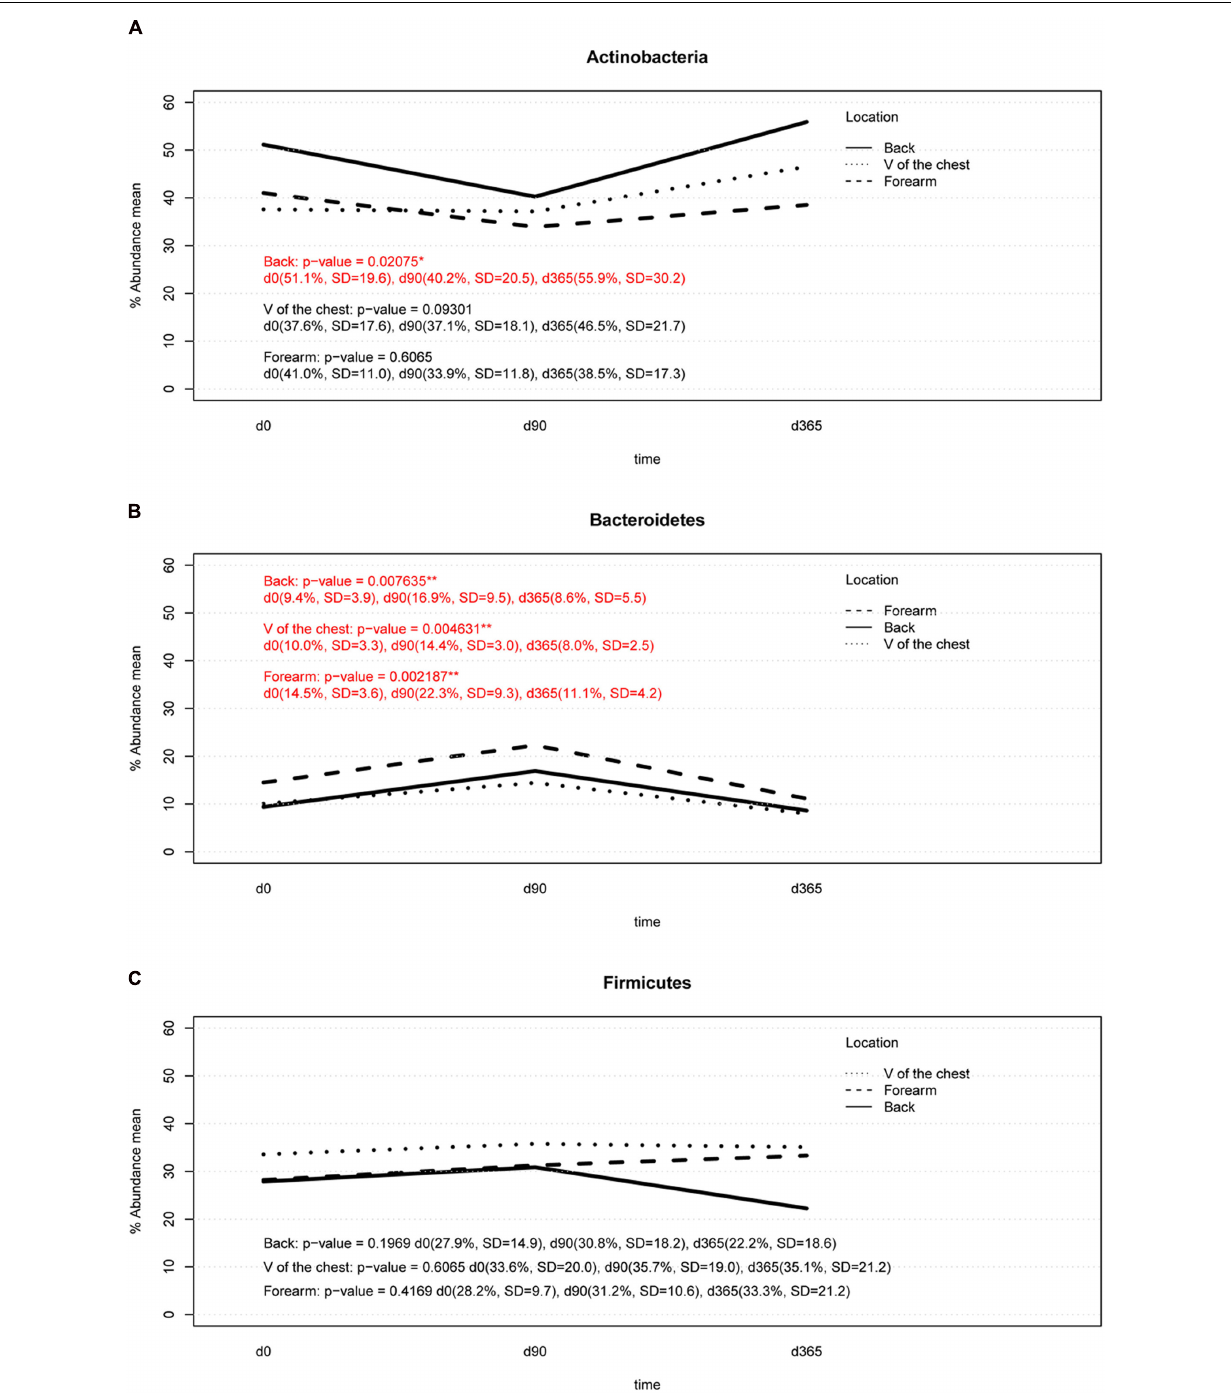
Frontiers in Microbiology |